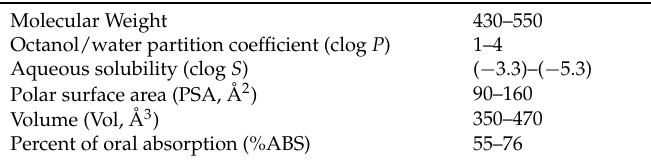
Table 7. Drug-like properties of the novel direct fxa